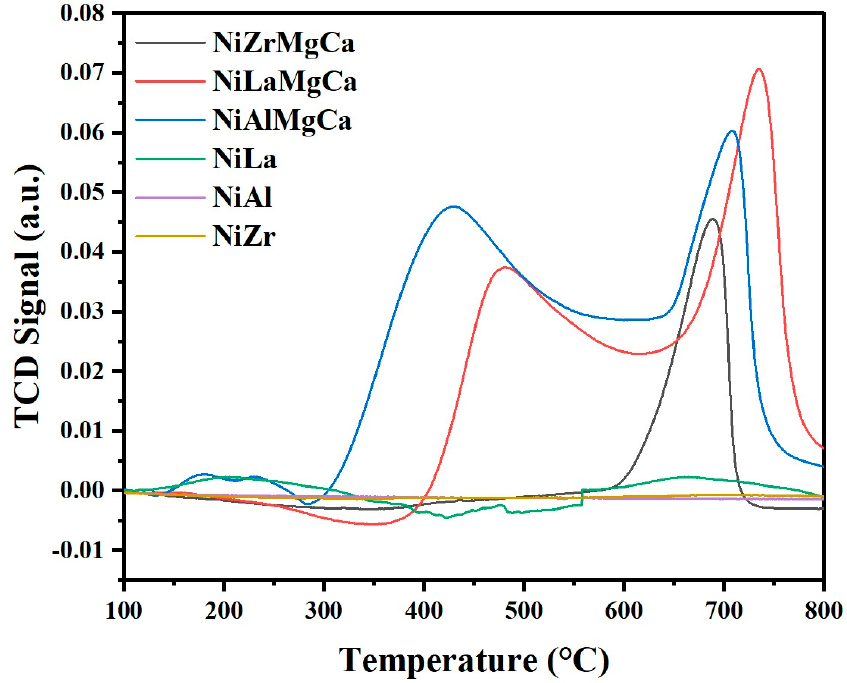
Figure 4. CO 2 –TPD profiles of reduced catalyst.